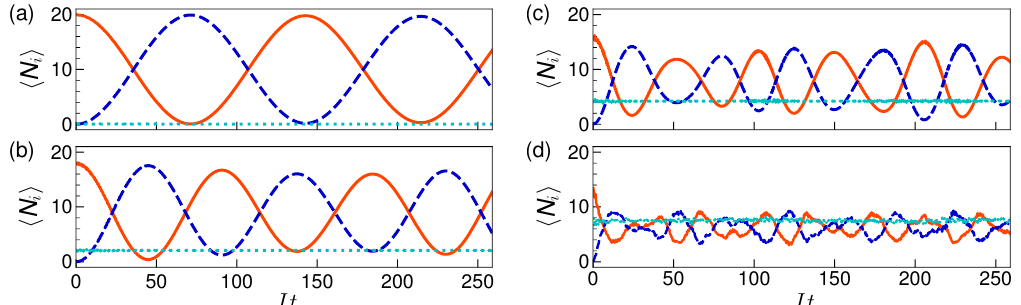
Figure 3: Expectation value dynamics. Dimensionless units are used. The panels 〉 , i = 1,2,3, with UN / J = 6 and the choice of initial states: (a) show results for 〈 N i | 20,0,0 〉 ; (b) | 18,2,0 〉 ; (c) | 16,4,0 〉 and (d) | 14,6,0 〉 . 〈 N 〉 by the dotted cyan line, and 〈 N solid red line, 〈 N 2